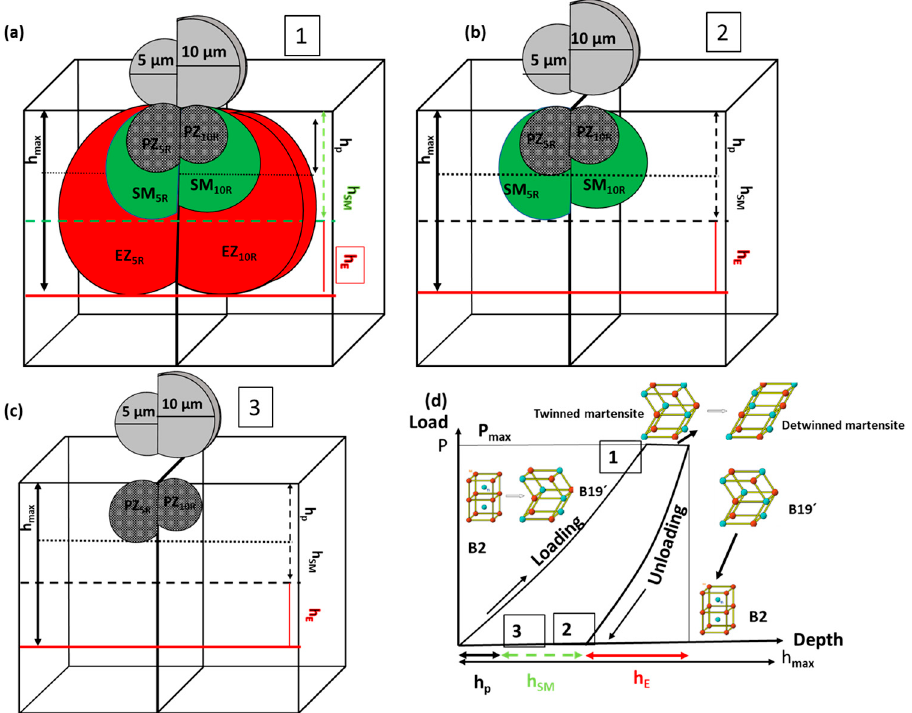
Figure 5. ( a – c ) Schematic diagram of indentation load and depth as the function of elastic, shape memory and plastic effect from shape memory alloy. (1–3) Different deformation zones plastic zone (PZ), shape memory (SM) zone and elastic zone (EZ) regions on maximum load, unload position and after shape recovery. Two different radii of an indenter with radii of 5 and 10 µm. ( d ) Depth of maximum depth from h max divided into height of elastic (h E ), SM (h SM ) and plastic (h p ) zones for B2 (austenite) and B19’ martensite phases.